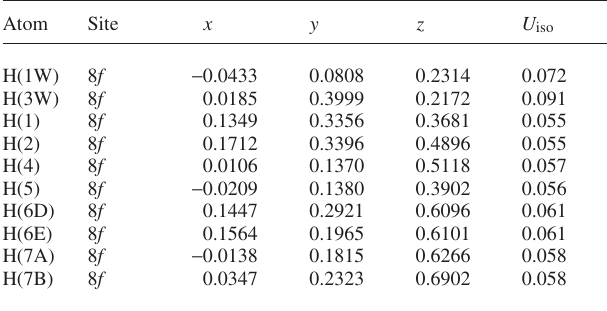
Table 2. Atomic coordinates and displacement parameters (in Å 2 )